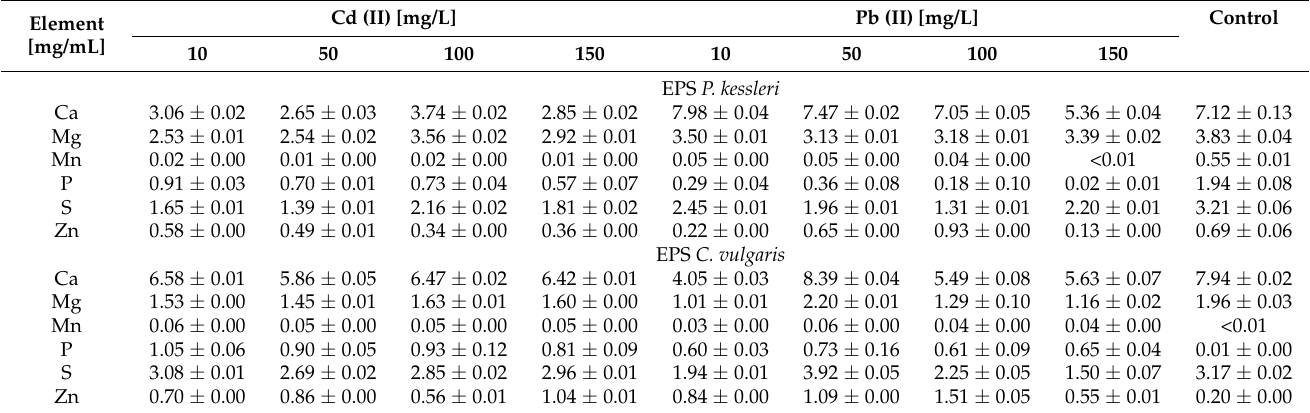
Table 5. The concentration of elements released from EPS to solution after cadmium and lead sorption in comparison to control sample (EPS dissolved in demineralized water) ( ±